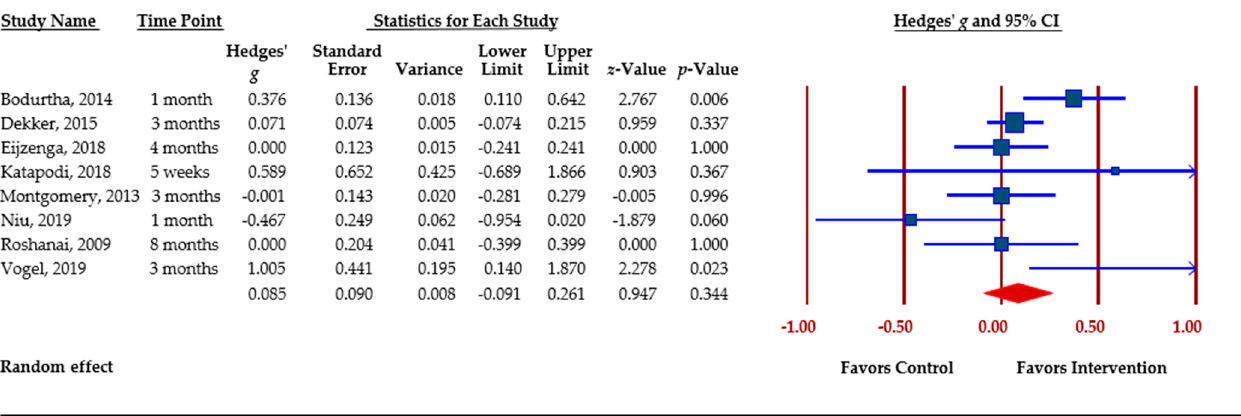
Figure 2. Family communication.